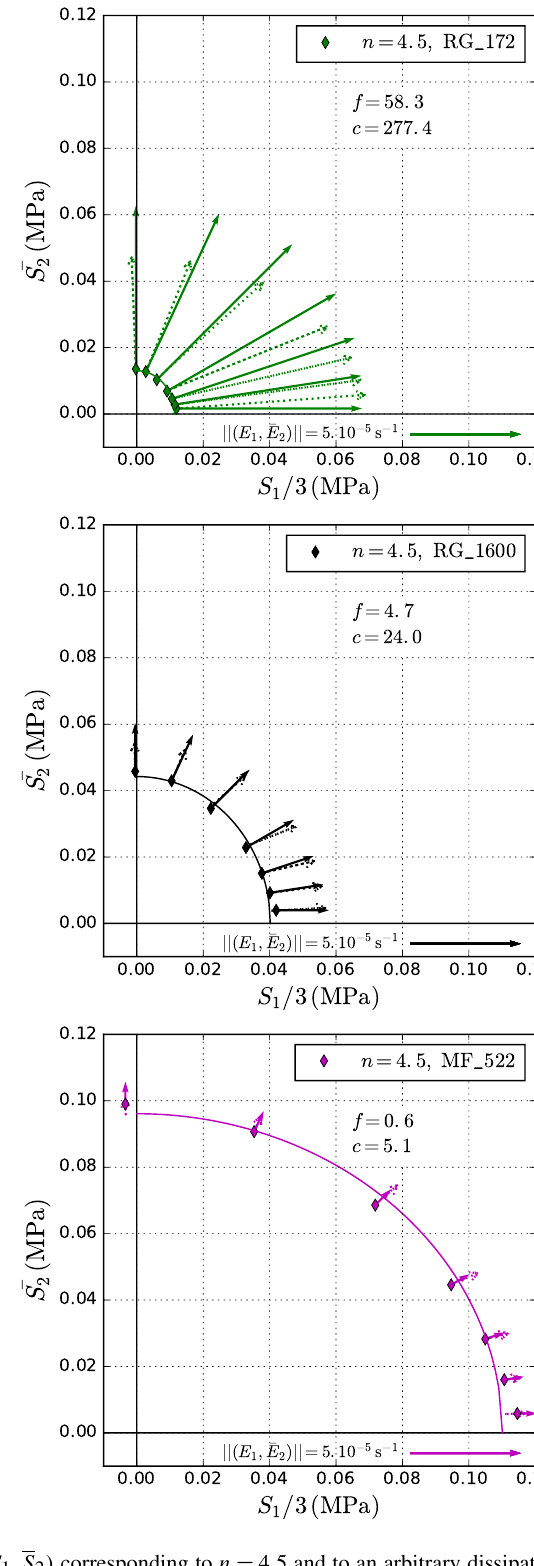
◦ ,E 2 ) are represented by solid 1